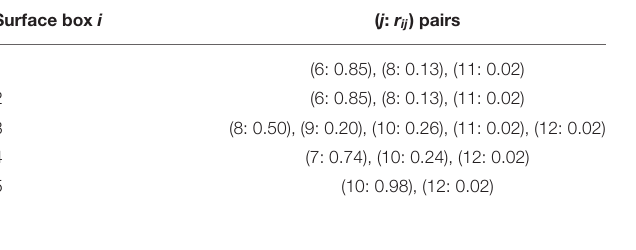
TABLE 3 | Fraction r ij of the export production from surface box i that is remineralized in deep-water box j . Surface box i